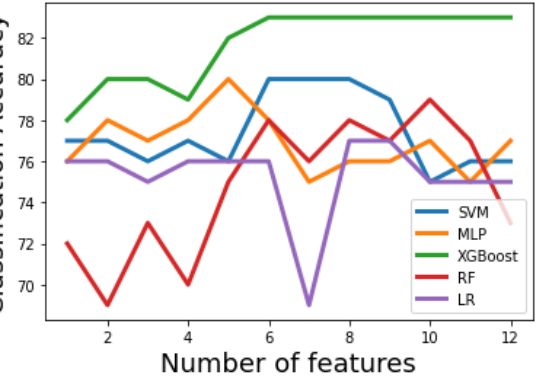
Figure 3. Accuracy curves for the machine learning models in stage 1. XGBoost classifier results in optimal accuracy.